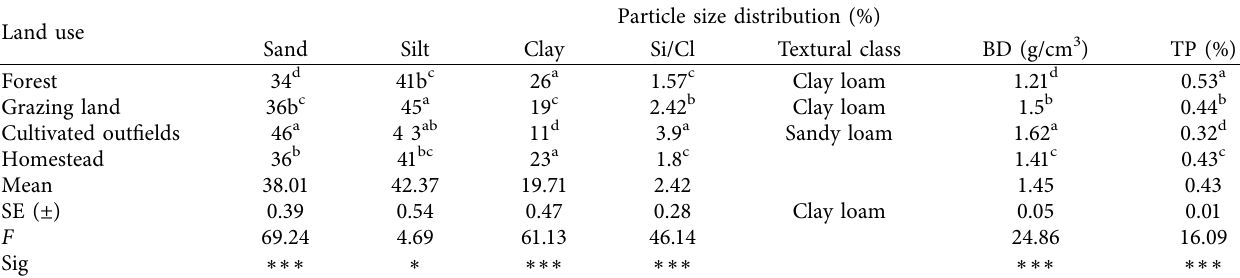
Table 2: Mean values of selected physical properties of soils as affected by different land uses.